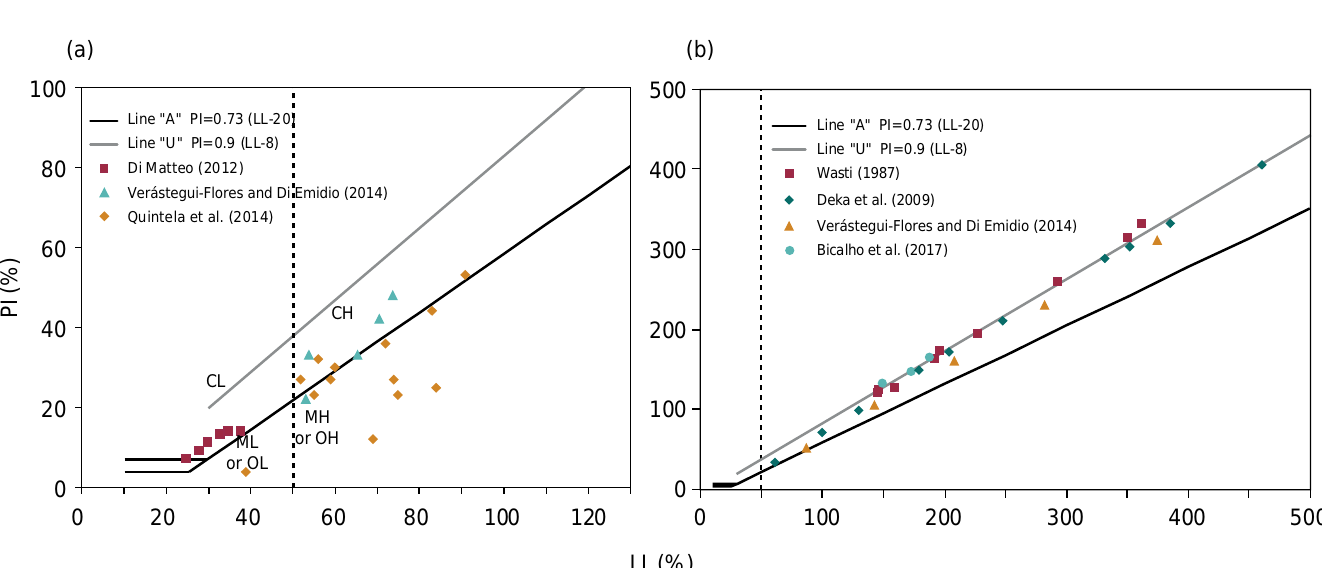
Figure 3. Location of the soils investigated in B-01i in the Casagrande chart (a) and location of the soils investigated in B-01ii in the Casagrande chart